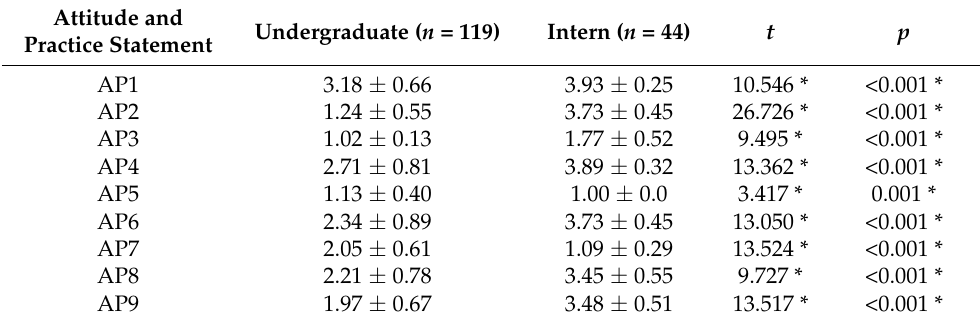
Table 7. Comparison between undergraduate students and interns according to the scoring of their attitude and practice statement